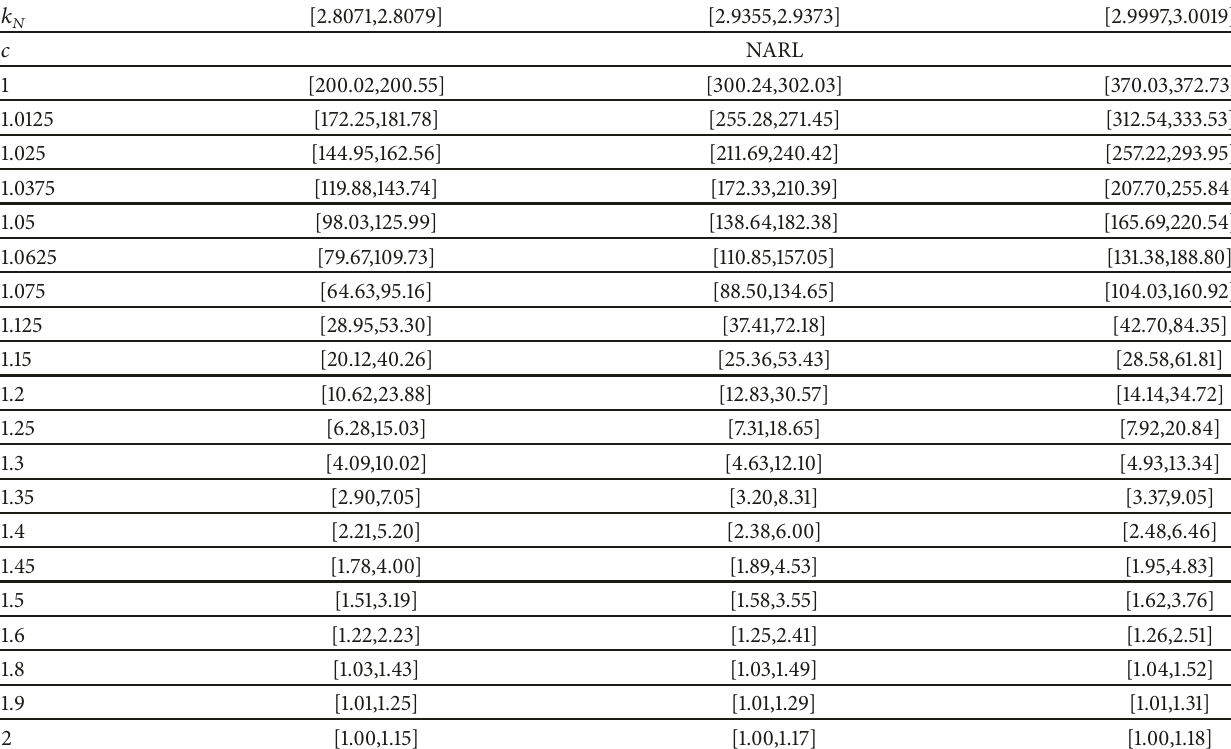
Table 1: The NARLs of proposed chart when V 𝑁 𝜖[0.4,0.6] and 𝑢 0𝑁 𝜖[2.5,3.5] . 𝑘